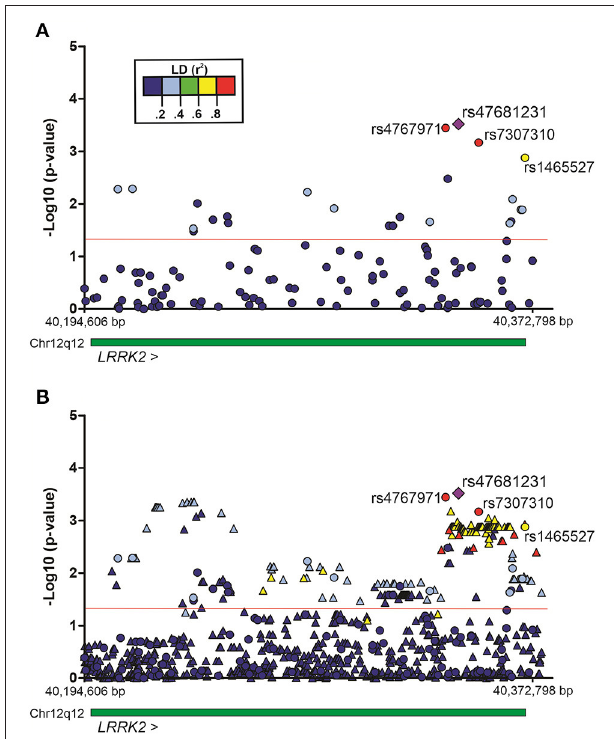
FIGURE 1 | Regional plots of multivariate logistic regression results on alcohol dependence in the population of Bambuí, Brazil. Analyses were conducted under an additive genetic model, with sex, age, and the first principal component as covariates. (A) Genotyped variants in the LRRK2 region. (B) Genotyped and imputed variants in the same region. Results [–Log 10 ( P -value)] for each variant are represented by circles (genotyped) or triangles (imputed). The purple diamond represents the top single-nucleotide polymorphism (SNP) rs47681231. The four SNPs highlighted in the figure were associated with alcohol dependence (after adjustment by false discovery rate, Benjamini–Hochberg). The green bar represents the extent of the LRRK2 gene. The red line indicates P = 0.05. Region view: 12:40,194,606–40,372,798 (RefSeq: GRCh38). Linkage disequilibrium (LD, r 2 ).